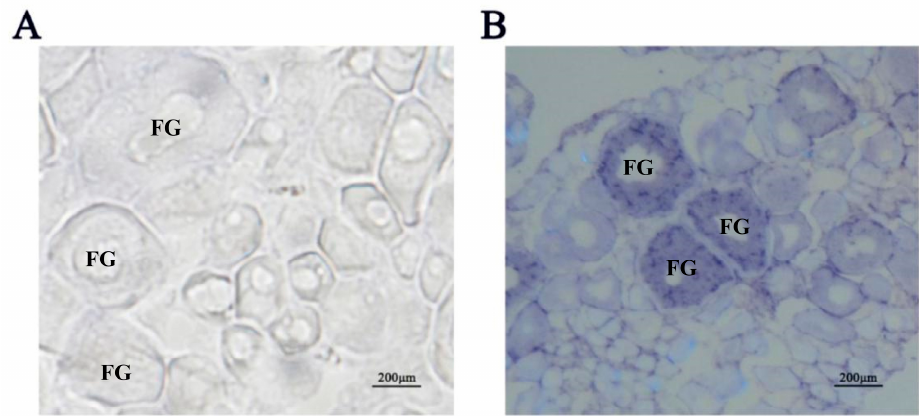
Figure 3. Distribution of igf3 mRNA in E. coioides ovaries from frozen tissue sections. ( A ) sense probe. ( B ) antisense probe. Note: FG indicates full grown stages of follicular.